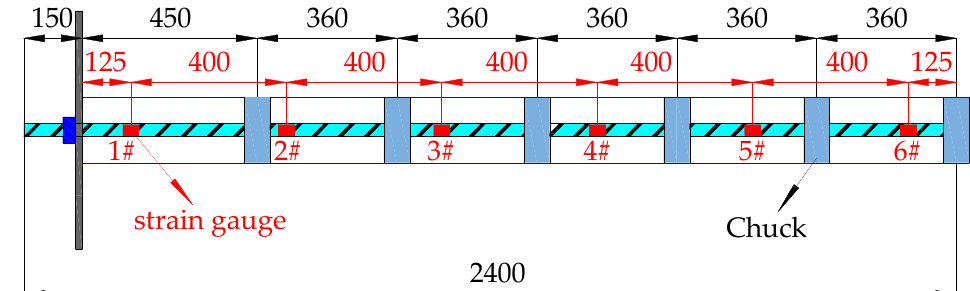
Figure 13. Layout of strain gauges.